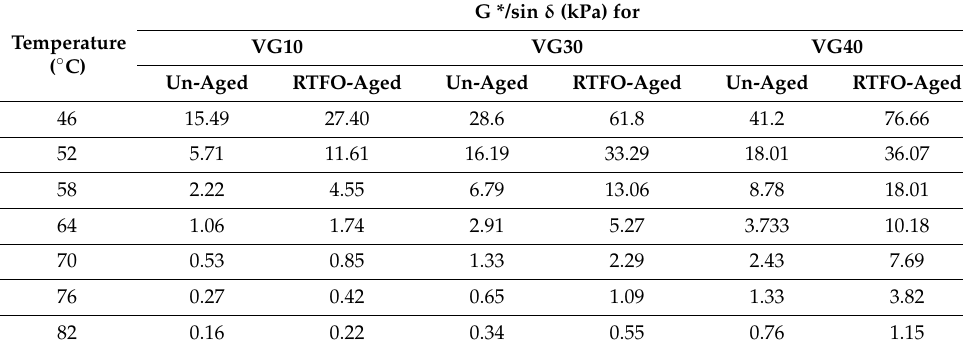
Table 7. G */sin δ for Virgin Binders.